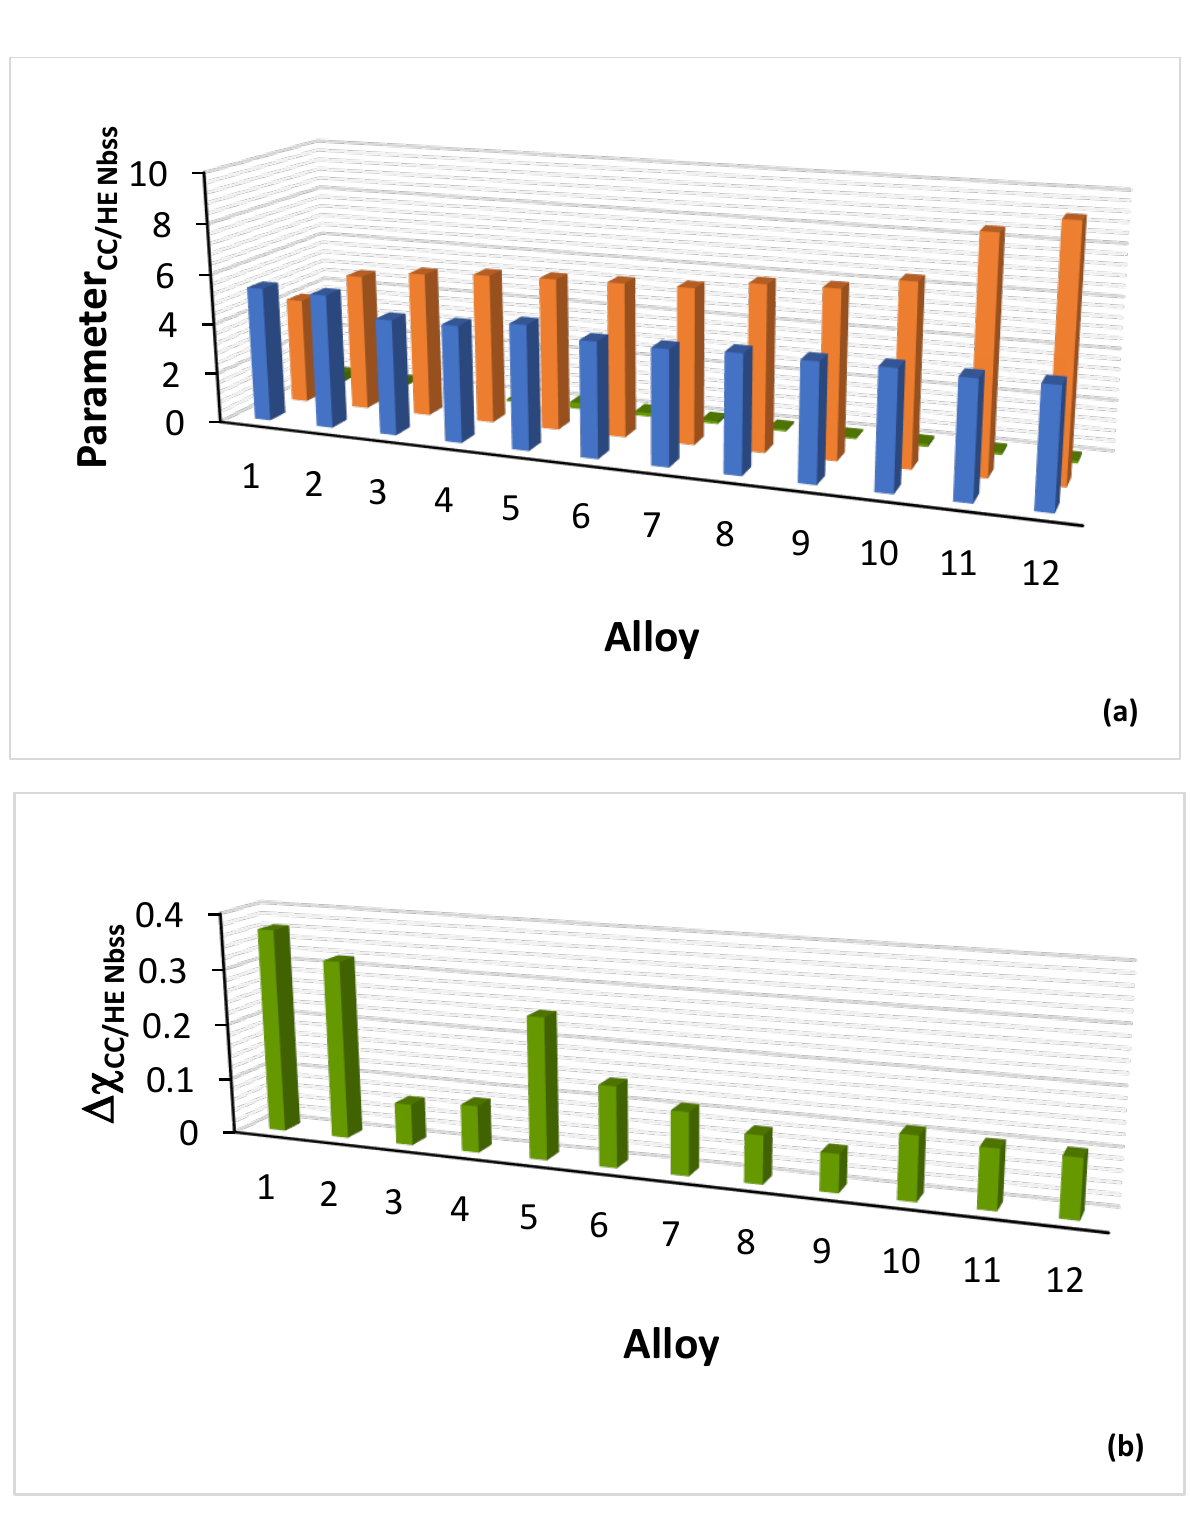
Figure 5. ( a ) Parameters VEC, δ and ∆ χ of CC/HE Nb ss in alloys where this type of solid solution was observed and ( b ) details of ∆ χ CC/HE Nbss. Colours: blue VEC, brown δ , green ∆ χ . Alloys 1 to 12 the same as in Figure 4. HE Nb ss in TT4-AC. For nominal alloy compositions and references